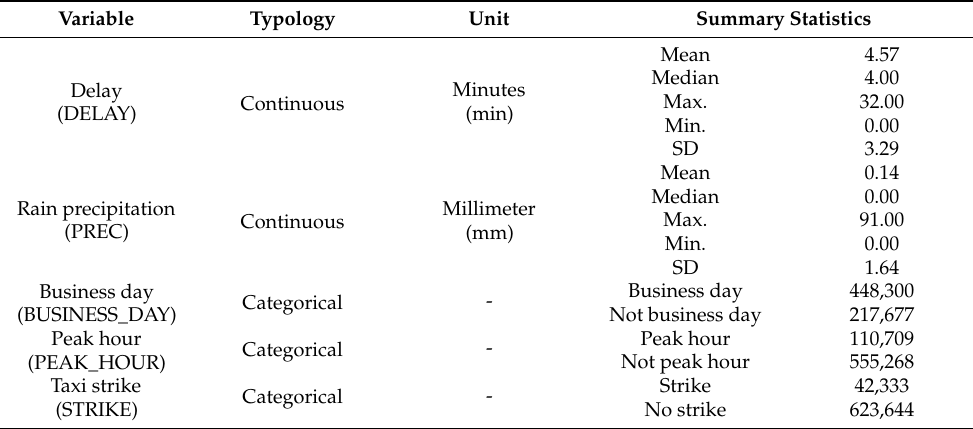
Figure 3. Boxplot of continuous variables.